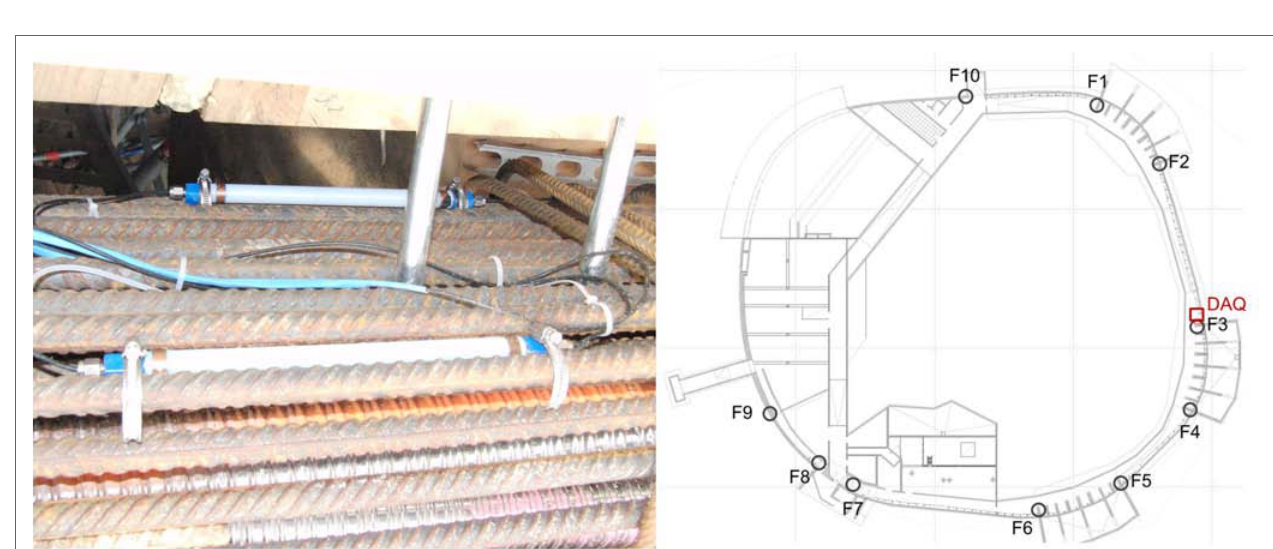
FIGURE 3 | Deflection of the roof after lowering onto the ring beam . Left, calculated deflection; right, measured deflection.